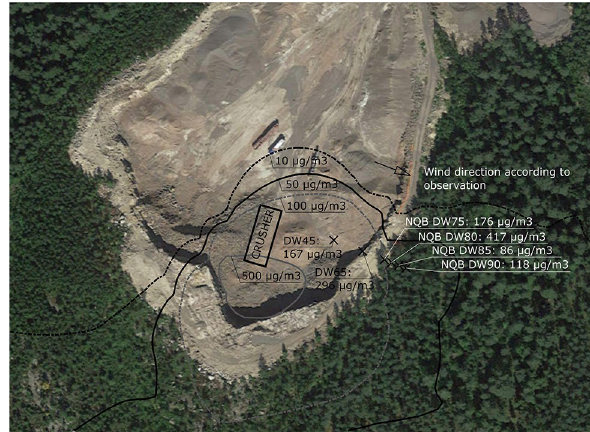
Fig. 6 Modelled concentration contours of the model C7 and the measured PM concentrations near four stages crushing. X is the 10 measurement location in the downwind (DW) direction. Aerial pho- tograph: Google Earth